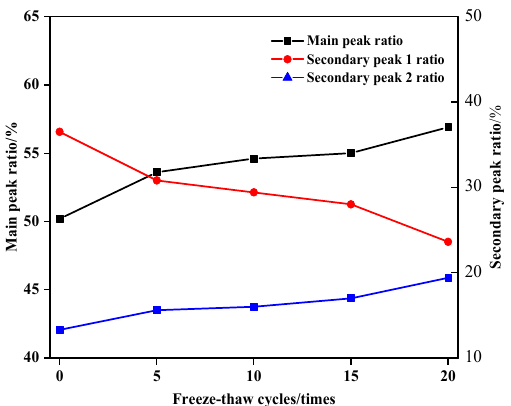
Figure 6. The variation curve of the proportion of pore volume in each peak with the number of freeze–thaw cycles.